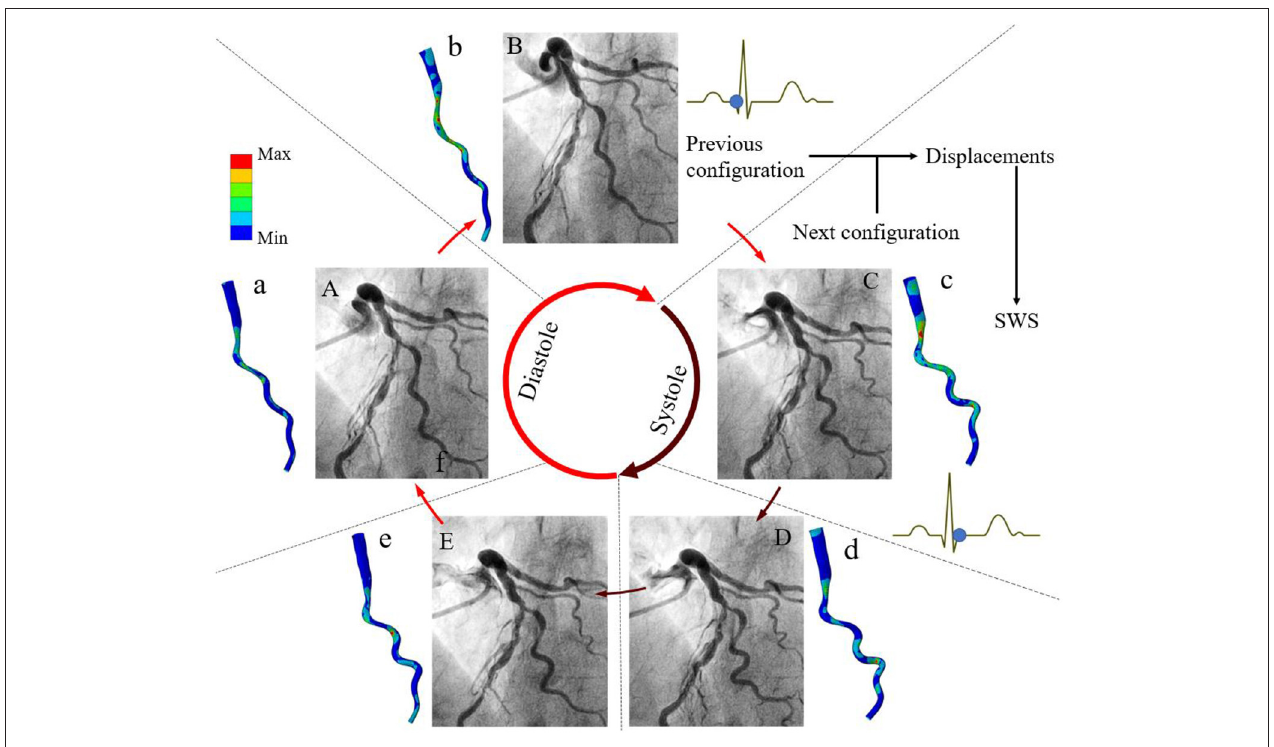
FIGURE 2 | Methods of angiography-based 4D coronary arterial wall dynamics assessment and calculation. Five frames corresponding to specific time-points during the cardiac cycle are identified from the electrocardiogram: (A) mid-diastole (diastasis), (B) end-diastole, (C) early-systole, (D) end-systole, and (E) early-diastole. Left coronary arteries present large deformations in vivo. The local displacements of the superficial wall are determined between these arterial geometries at two consecutive time instants. By using global point-wise displacement mapping relationship on the arteries at the current time-point, the wall strain is determined. Considering the material properties of normal and fibrous tissues, superficial wall stress is further calculated (a–e) . Modified from Wu et al. (